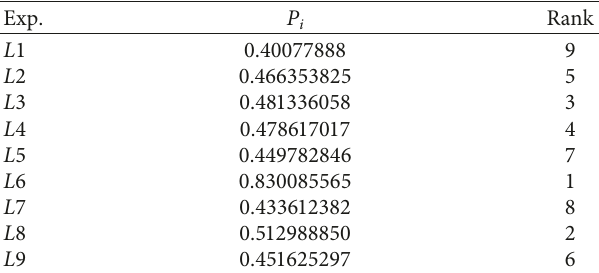
Table 20: Rank of the performance matrix.